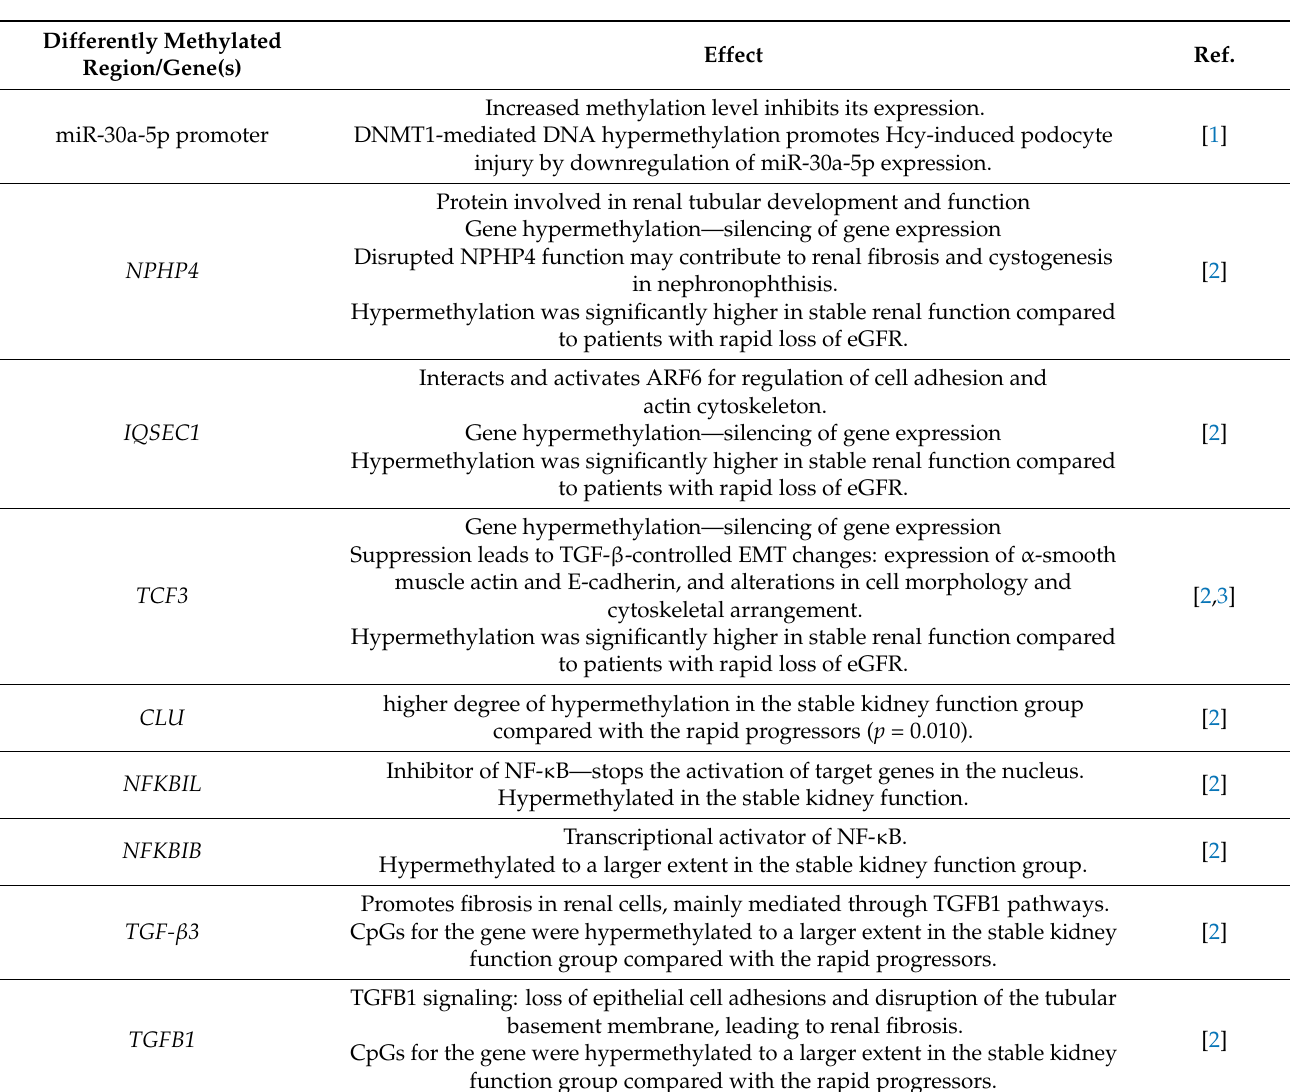
Table 1. Examples of genes which altered methylation and were suggested to be involved in CKD